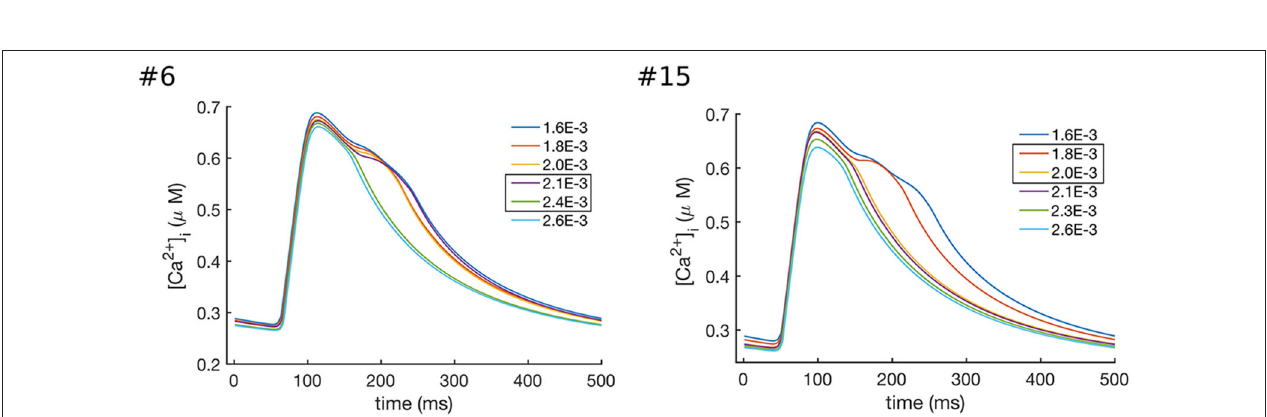
FIGURE 7 | Effects of increasing the values of I max NaK in models #6 and #15, which resulted in the enhanced Ca 2 + extrusion and a faster CaT c decay. In model #6 the transition between the biphasic and smooth CaT profile occurred at values of I max NaK between 2.1 × 10 − 3 and 2.4 × 10 − 3 n S /pF, while in model #15 the transition occurred at values between 1.8 × 10 − 3 and 2.0 × 10 − 3 n S /pF.